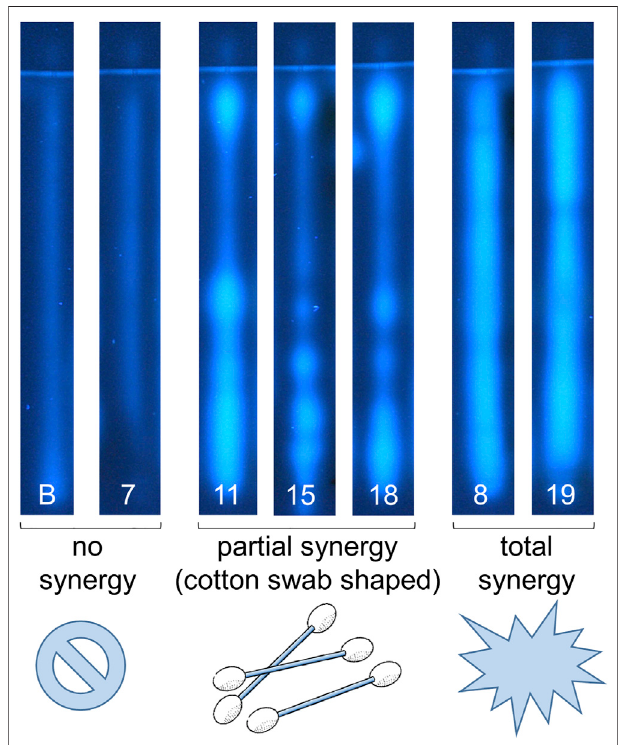
FIGURE 6 | First report of synergy pro fi les, exemplarily shown for the NP-HPTLC-pYAESbioassay.Separationoftheappliedbotanicals(nos.7 – 19, assigned in Table 1 ; 4 µl/band each; solvent blank B for comparison) on HPTLCplatesilicagel60F 254 MS-gradewithethylacetate — toluene — formic acid — water (16:4:3:2, V/V/V/V ) up to 70 mm; each separated track was oversprayed by an 1 mm × 70 mm area of 17- β -estradiol (10 ng/band) and after bioassay application detected at FLD 366 nm. Forti fi ed estrogenic fl uorescence was interpreted as synergistic effects, which were not observed insolventblankBandno.7(onlyaslightanti-estrogeniceffectinthelower hR F range), partially observed as cotton-swab-shaped 17- β -estradiol band (nos. 11, 15 and 18) or as overall broadened estrogenic band (nos. 8 and 19), if compared to the solvent blank B, which shows reference 17- β -estradiol fl